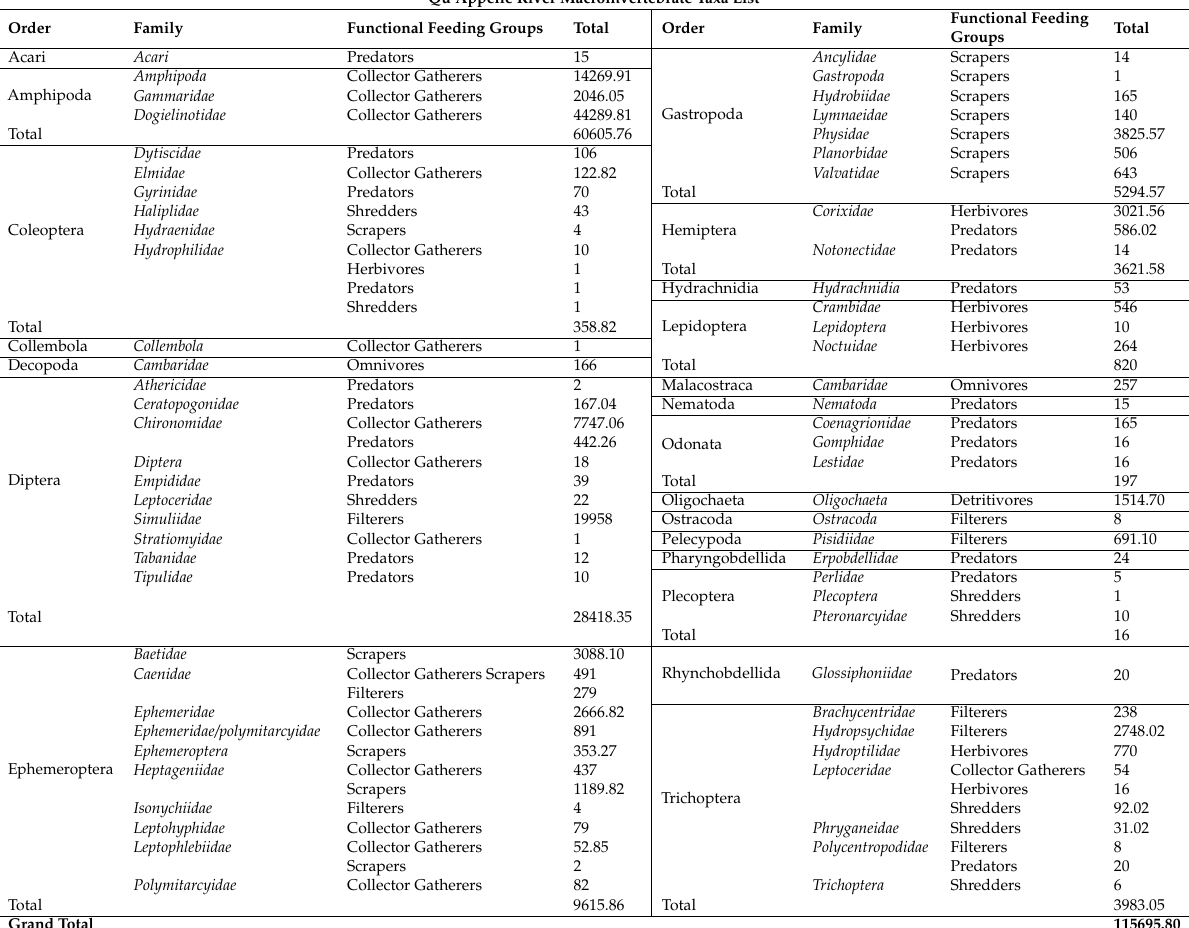
Table A1. Qu’Appelle River macroinvertebrate taxa list, including order, family, functional feeding group, and